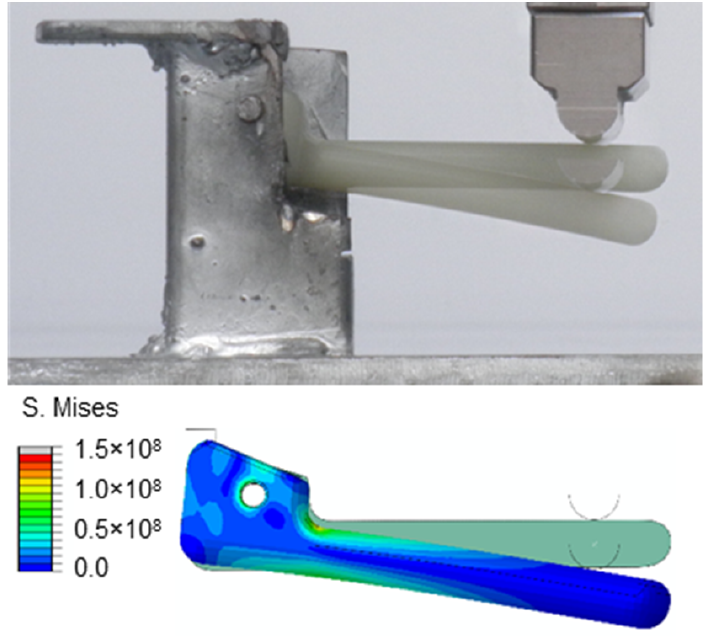
Figure 8. The unloaded and loaded (8 mm deflected) door handle in reality ( above ) and in simulation ( below ).